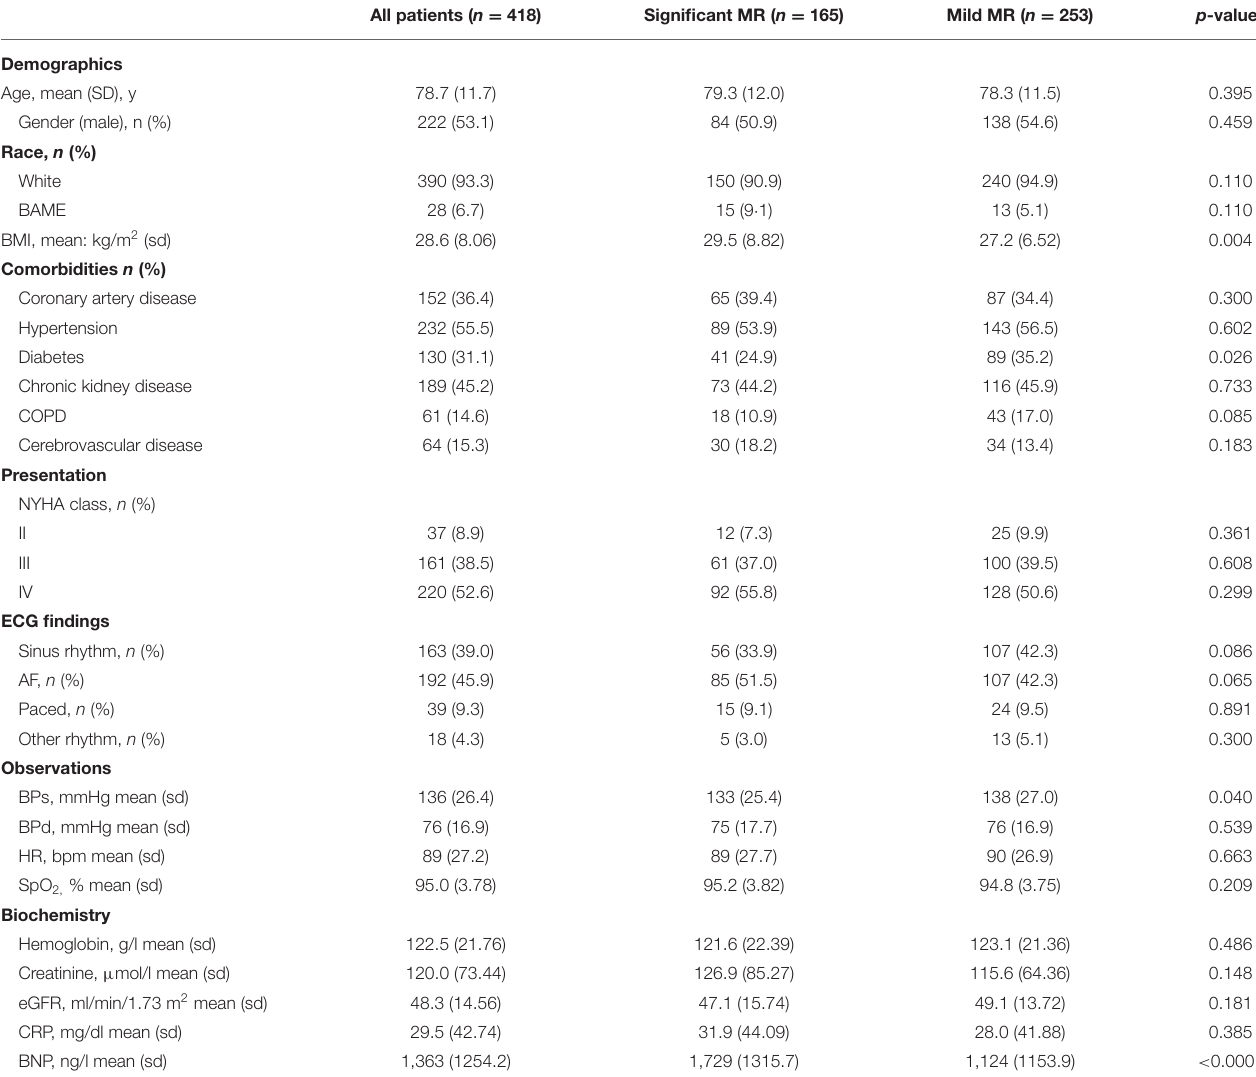
TABLE 1 | Baseline